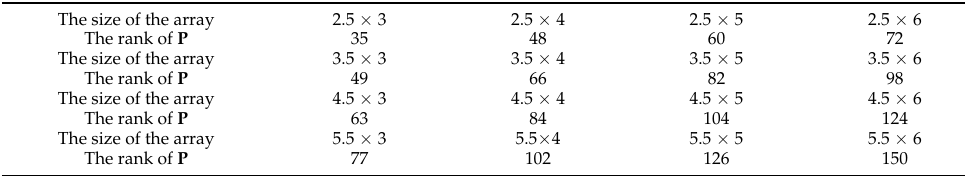
Table 5. The Ranks of the Third Case. The size of the array